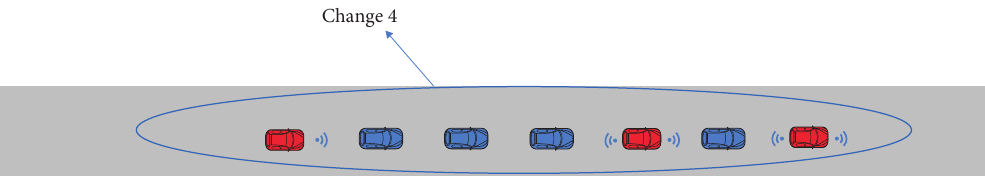
Figure 10: The irregular alignment of the fleet.